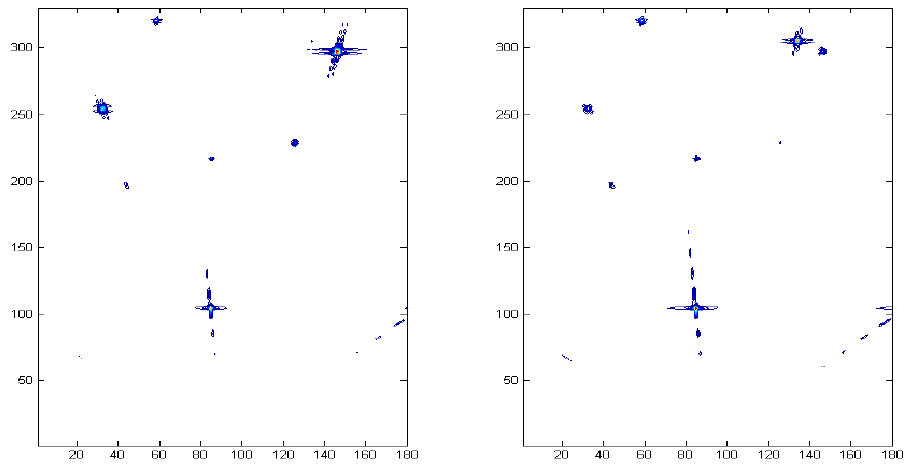
Fig. 10. Comparative images for two-channel radar with continuous-waveform radiation, only the 10 brightest reflectors are